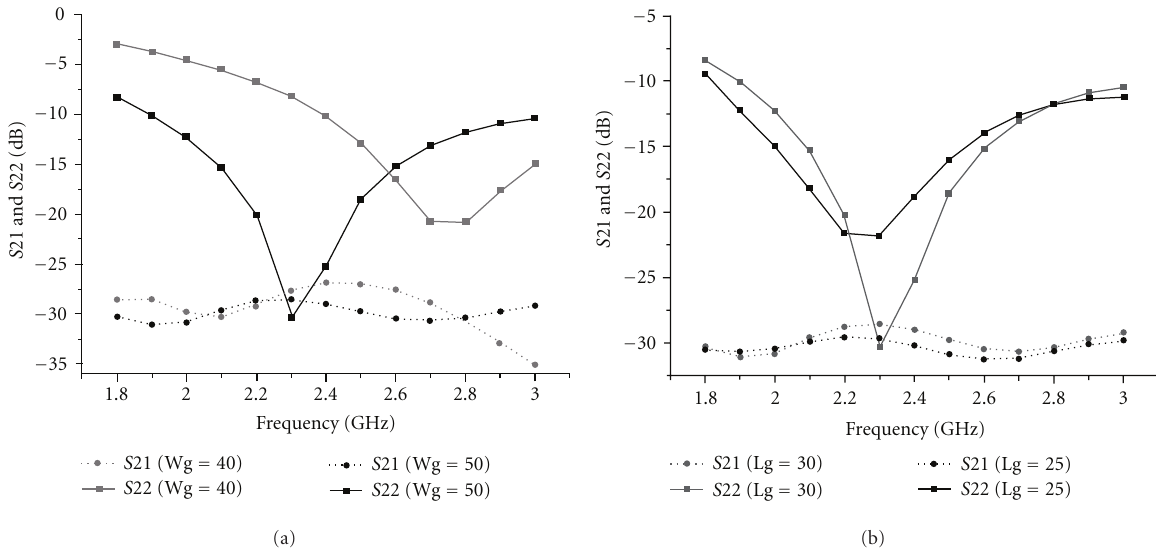
Figure 12: The e ff ect of the ground dimension, (a) ground width Wg and (b) ground length